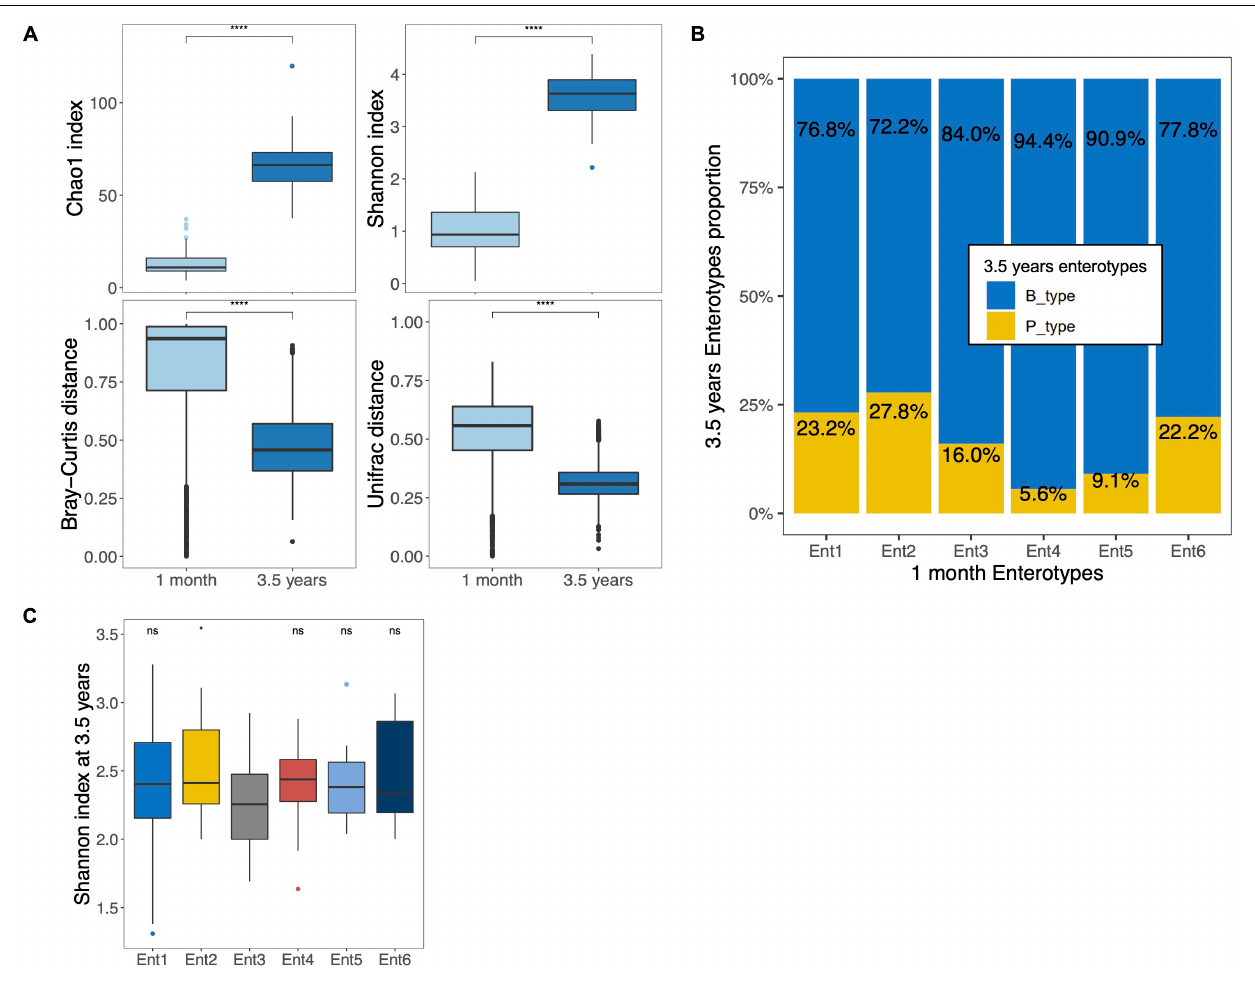
FIGURE 4 | Comparison of the gut microbiota of the same preterm children at 1 month and 3.5 years of age. (A) Boxplots of alpha (top) and beta diversities (bottom) based on both Chao1 and Shannon index and both Bray–Curtis and Unifrac dissimilarity distances, respectively, at genus taxonomic level in the 141 preterm children with sequencing data at two time points. (B) Distribution of B_ and P_type enterotypes among the six enterotypes at 1 month in 159 preterm children with a fecal sample at two time points. The values are expressed as proportions of each enterotype at 3.5 years of age among each enterotype at 1 month. (C) Boxplots of Shannon diversity based on genus level at 3.5 years of age according to enterotype at 1 month (* p < 0.05, ns = p > 0.05; Reference group = Ent3, Ent, Enterotype). The boxplots show the smallest and largest values, 25 and 75% quartiles, the median, and outliers. **** p <